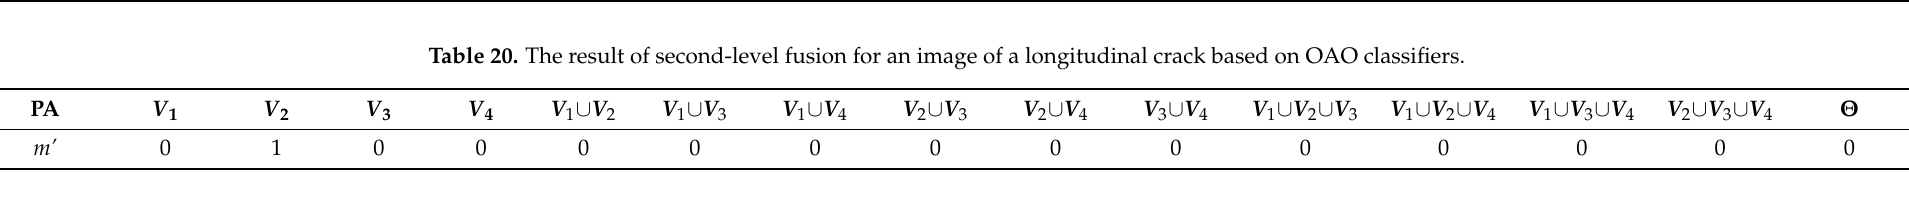
Table 21. The result of second-level fusion for an image of an oblique crack based on OAO classifiers.